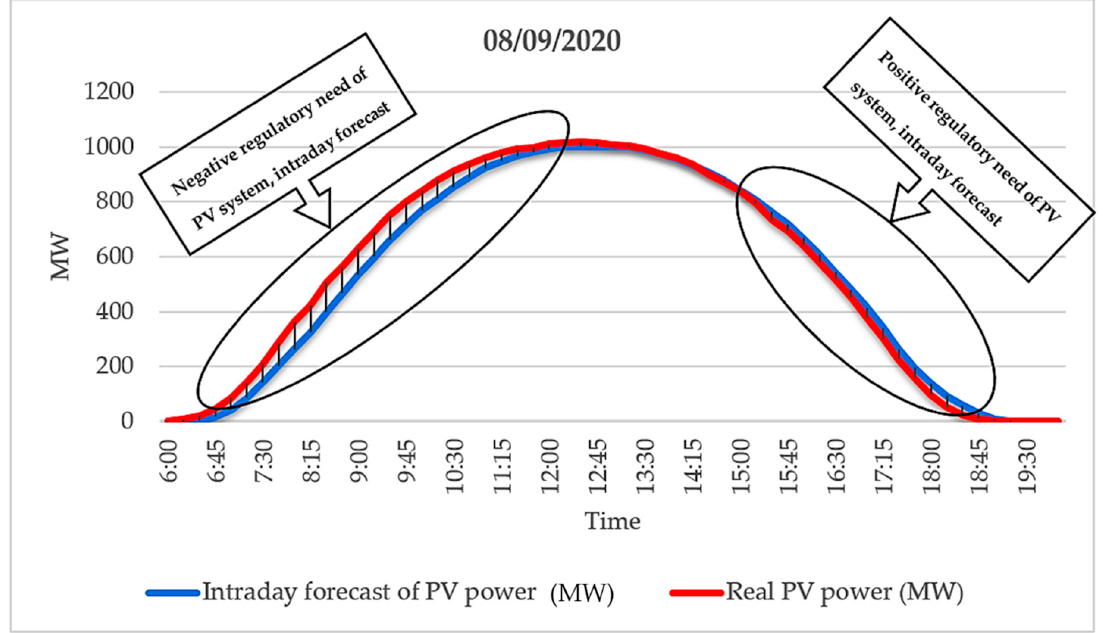
Figure 2. A Hungarian example to illustrate the deviation of real PV power generation and intraday forecast data in the case of a monitored 1196 MWp PV system, 8 September 2020. [81].